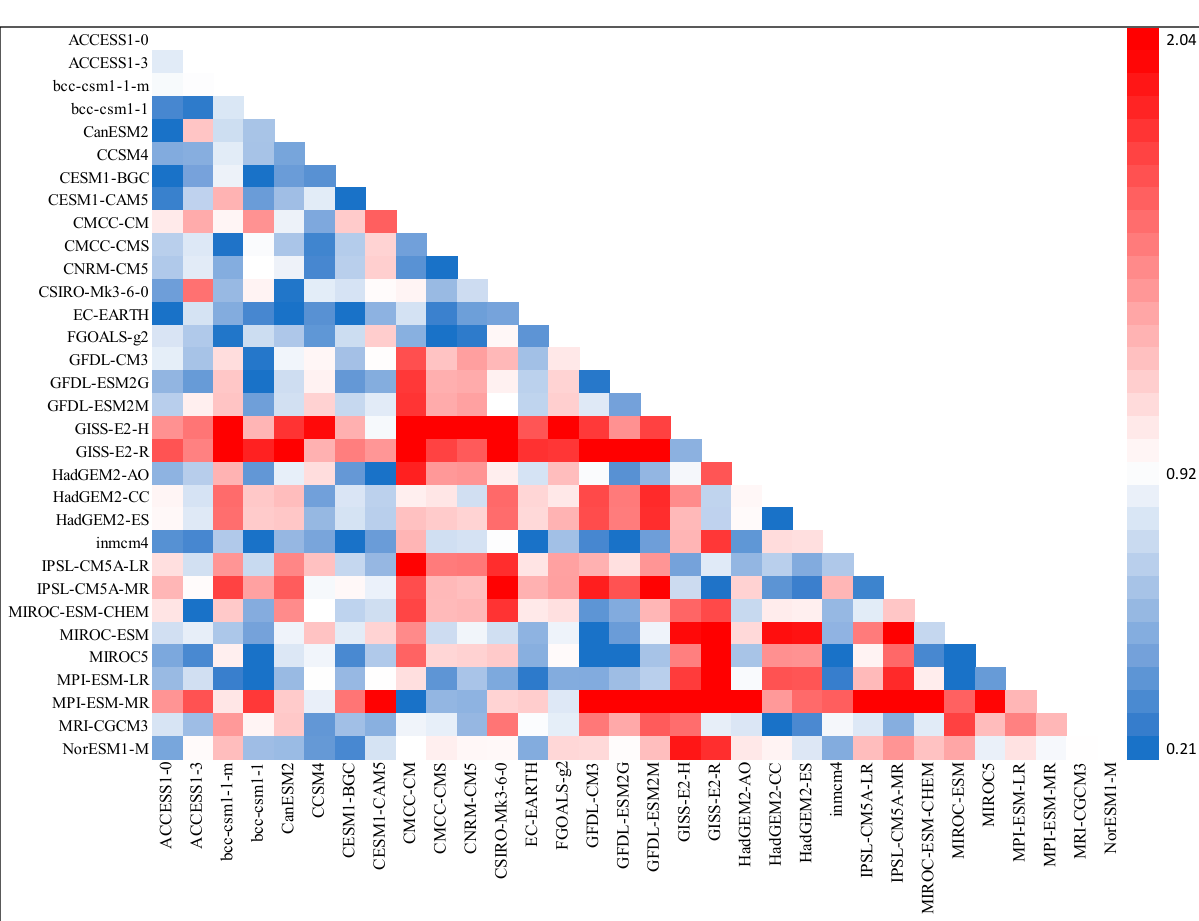
Figure 3. Multi-variate inter-model distance matrix [17,23] developed for calculation of the Géoviticulture multicriteria climate classification viticulture climate classification index for the Willamette Valley American Viticultural Area using the Localized Constructed Analogs (LOCA) Coupled Model Intercomparison Project phase 5 (CMIP5) model archive [40,41] for its defined historic period (1950–2005). Red matrix entries depict pairwise independent models, whereas entries colored blue denote pairwise models whose datasets are closer in agreement and demonstrate more co-dependence.